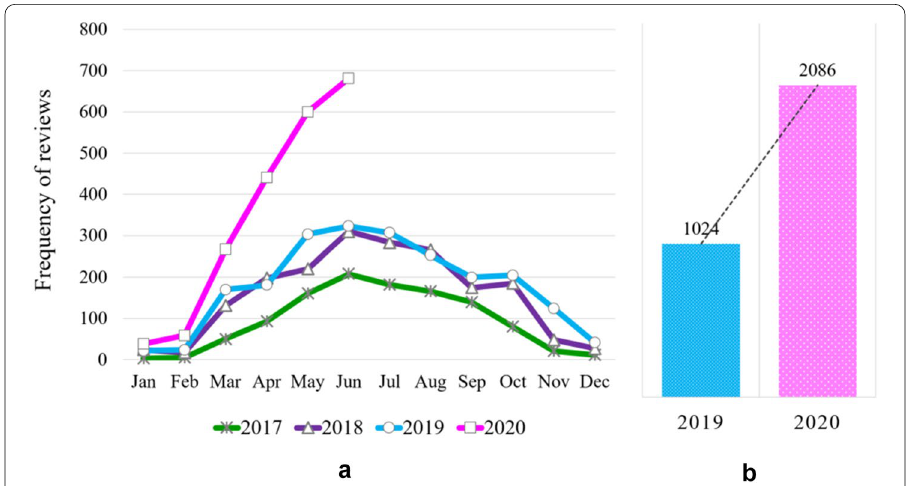
Fig. 2 Review frequencies for cycling pants; a monthly reviews from 2017 to 2020, b total number of reviews from January to June 2019 and 2020